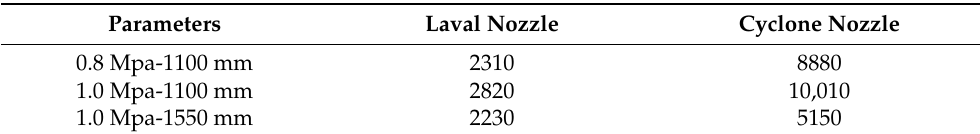
Table 4. The average value of the turbulent kinetic energy of Laval and cyclone nozzle at the inter- between oxygen and slag under different operating pressures and lance heights. face between oxygen and slag under different operating pressures and lance heights.